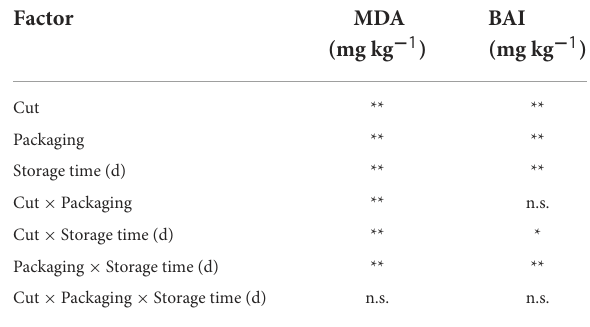
TABLE 3 Anova matrix results for significative descriptor on TBARS (MA, mg kg-1) and BAI (mg kg − 1 )